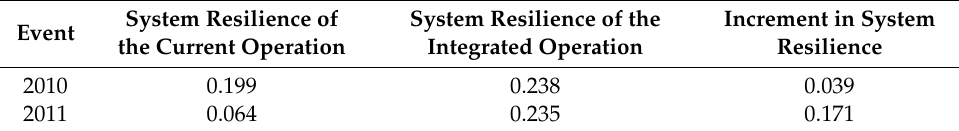
Table 10. The results of system resilience for current and integrated